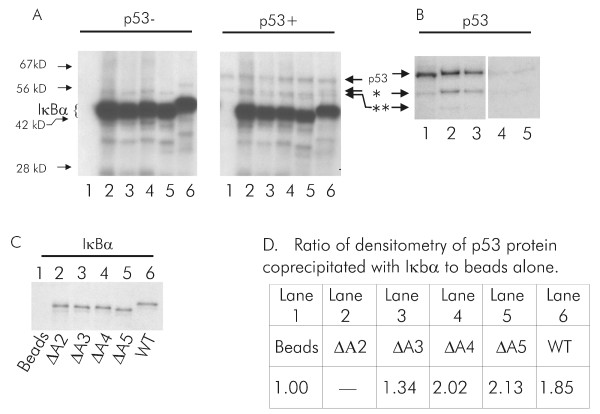
Rabbit reticulocyte lysate (RRL) produced p53 and IκBα proteins interact in vitro. A. Wild-type IκBα and mutant proteins were synthesized in rabbit reticulocyte lysates (lane 1, RRL no RNA; lane 2, ΔA2; lane 3, ΔA3; lane 4, ΔA4; lane 5, ΔA5; and lane 6, wild-type) and precipitated with a rabbit polyclonal antiserum against the C-terminus of IκBα using protein A/G sephadex beads either in the absence (p53-) or in the presence (p53+) of RRL synthesized, [35S]-labeled, p53. Equal volumes of RRL were used in all cases. For p53- reactions, RRL programmed with empty vector was incubated with [35S]-labeled methionine. A control reticulocyte lysate without IκBα protein template (lane 1) was included in these experiments. ΔA2 (lane 2), ΔA3 (lane 3), ΔA4 (lane 4) ΔA5 (lane 5) and wild-type (lane 6) IκBα proteins were co-incubated with p53, precipitated and analzyed by SDS-PAGE followed by radiography. B. Wild-type p53 protein translated in RRL (lane 1) produced both putative full-length p53 protein (denoted p53, mobility approximately 55 kD) and also at least two less-than-full length translation products (denoted * and **; lanes 1–3). Putative full-length and less-than full-length p53 translation products were precipitated by p53-specific monoclonal antibodies and protein A/G sephadex beads (lane 2, Ab1 recognizing the carboxyl terminus of p53; lane 3, Ab2 recognizing the amino terminus of p53). Less-than full-length proteins were more readily precipitated by Ab1 than Ab2. Control precipitation with IgG2A immunoglobulin (lane 4) or protein G/A beads (lane 5) did not precipitate p53. C. IκBα proteins were precipitated in similar quantities by IκBα antiserum. A shorter exposure of the gel than in panel A is shown. D. Densitometry of p53 protein precipitated in association with various IκBα alleles. Data shows significant precipitation of p53 with ΔA4, ΔA5 and wild-type, expressed as a ratio of label precipitating with IκBα allele to beads alone. Data was calculated by first normalizing to the background in each lane followed by calculating the ratio of label precipitating with IκBα to a corresponding area in the beads alone lane.